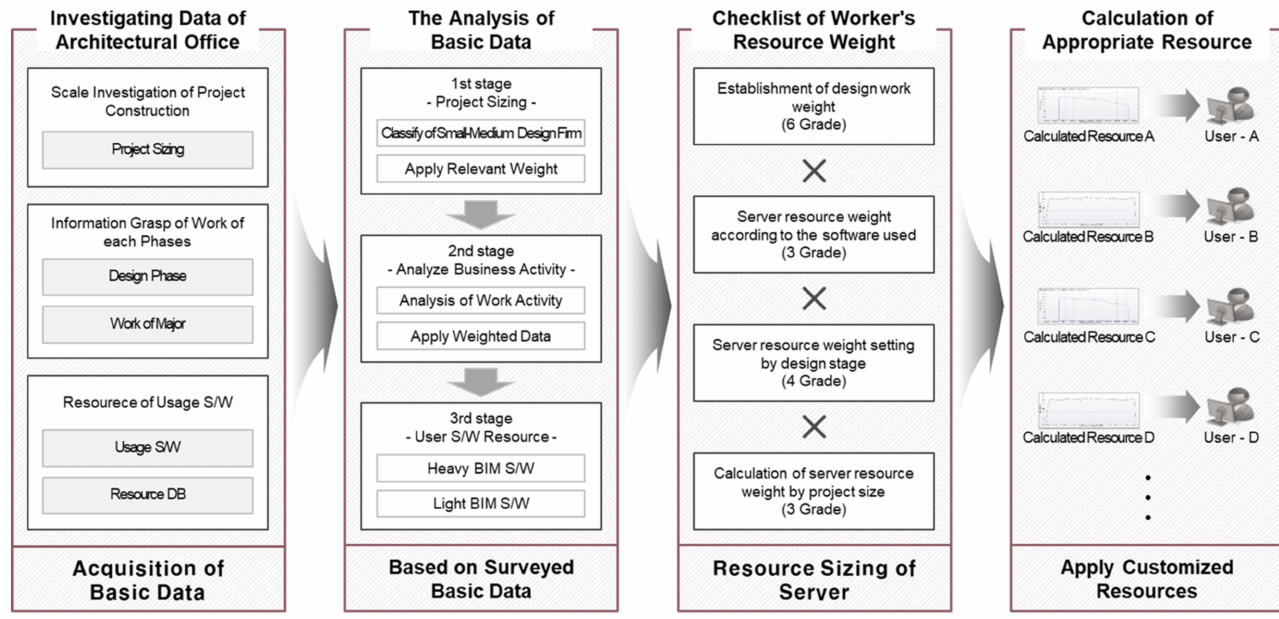
Figure 5. Basic data analysis of BIM users for the application of customized